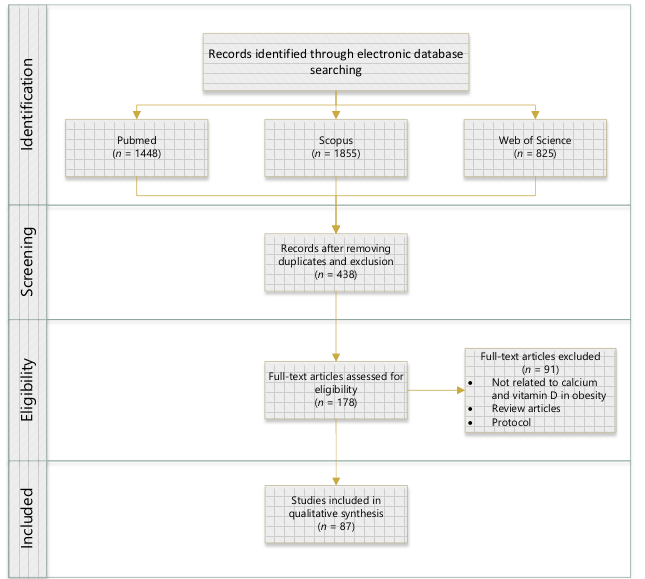
Figure 1. Flowchart of identifying, screening, selecting, and determining the literature search. ( n = numbers).